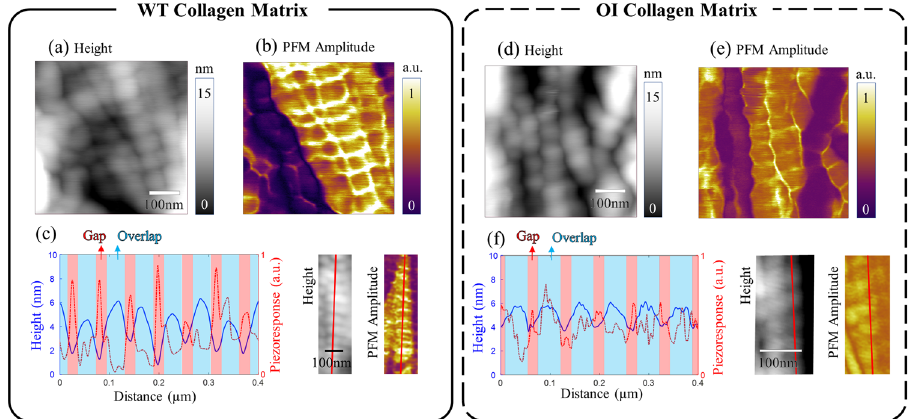
Fig. 2 Structural and piezoelectric properties of WT and OI collagen measured by PFM. a Height and b PFM amplitude maps of WT collagen matrix obtained by resonance-enhanced PFM, and c height and piezoresponse pro fi les of WT collagen fi bril along the red lines shown in images on the right obtained by DART-PFM. d height and e PFM amplitude maps of OI collagen matrix obtained by resonance-enhanced PFM, and f height and piezoresponse pro fi les of OI collagen fi bril along the red lines obtained by DART-PFM. The piezoelectric pro fi le of the WT collagen revealed a clear periodic pattern along with the collagen fi brillar direction with peaks at each gap region, while the piezoelectric pro fi le of the OI collagen was randomly varied along the fi bril without strong correlation with the